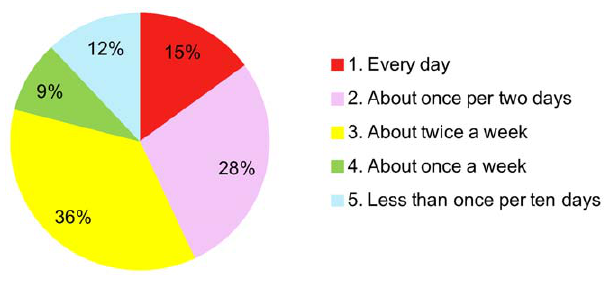
Figure 2. Results of the fidelity assessment of the program in the intervention